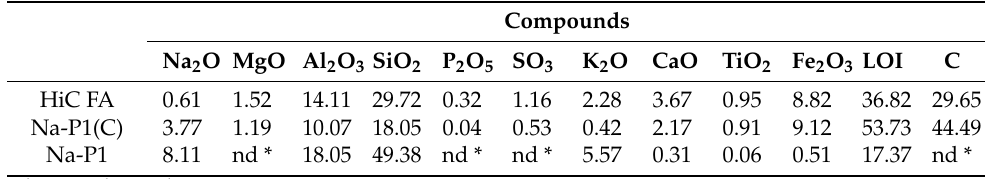
Table 1. Chemical composition of adsorbents: high-carbon fly ash, zeolite–carbon composite and zeolite.